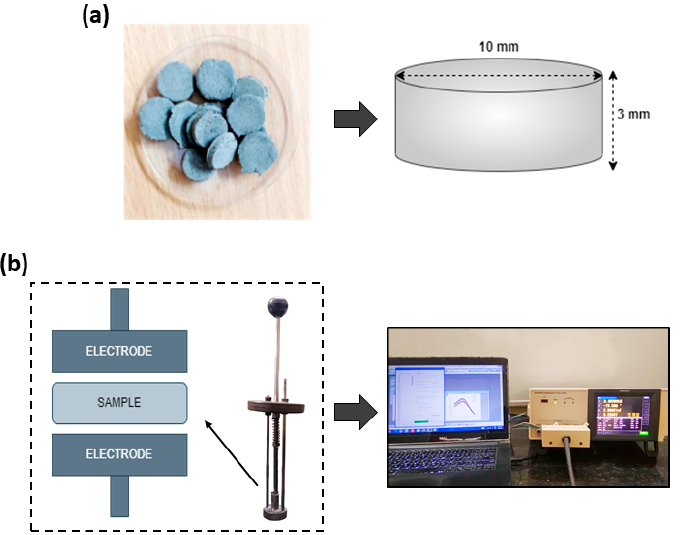
Figure 1. GRGC characterization process: ( a ) specimen specifications and ( b ) SSIS measurement methodology.